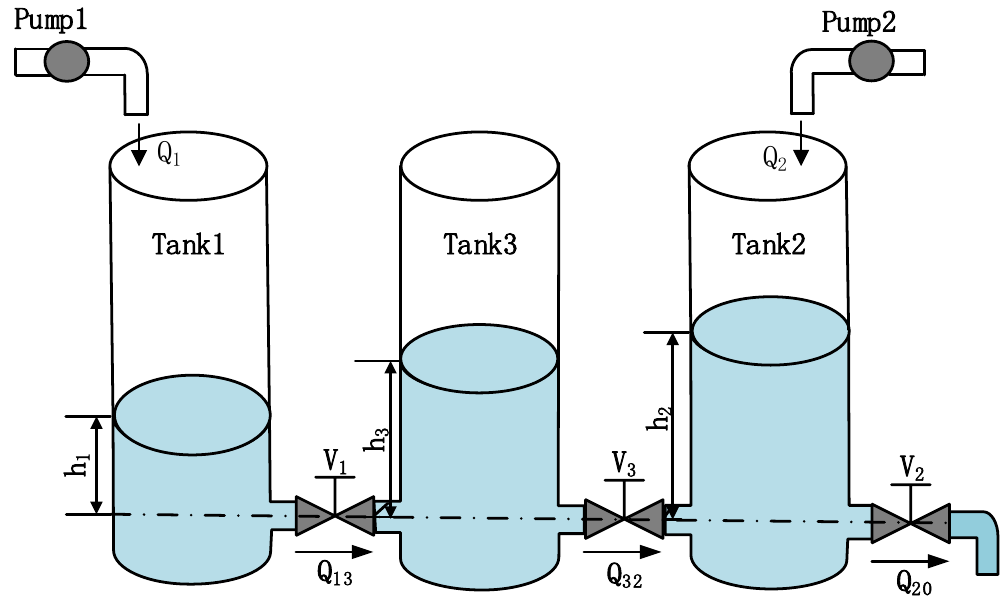
Figure 3. Three tanks